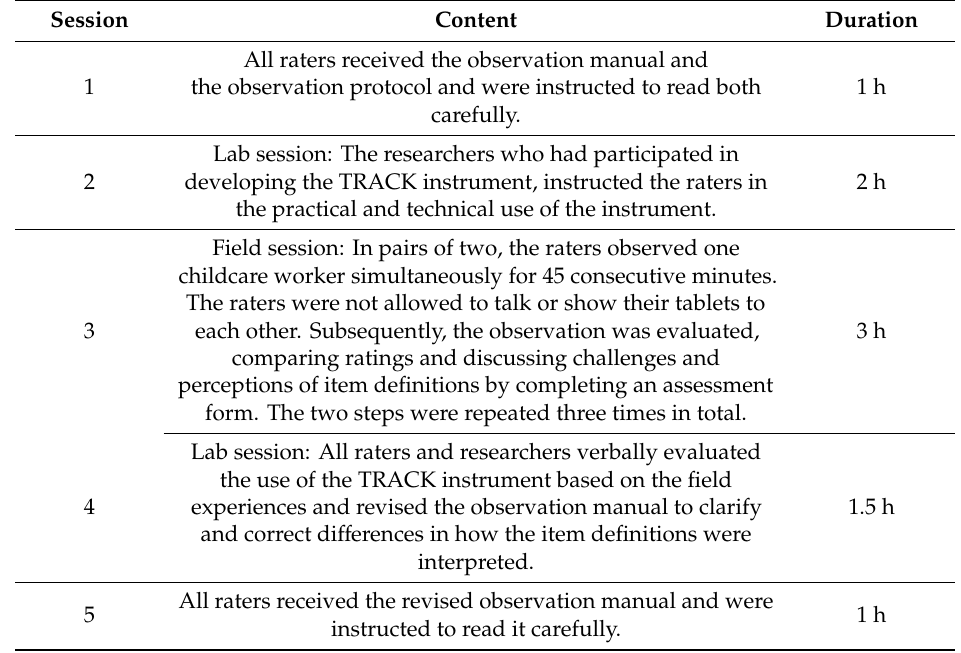
Table 2. Overview of the training of the raters. The rater training was completed over two weeks before the raters were to conduct observations out at